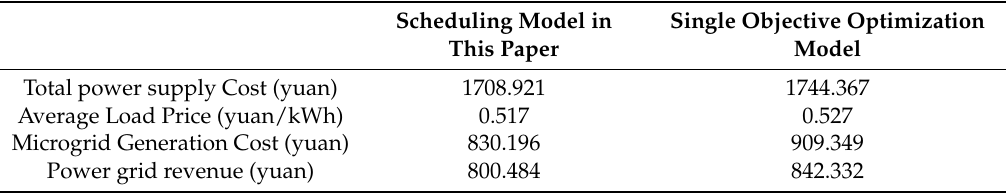
Table 3. Comparison between scheduling model in this paper and single objective optimization model.